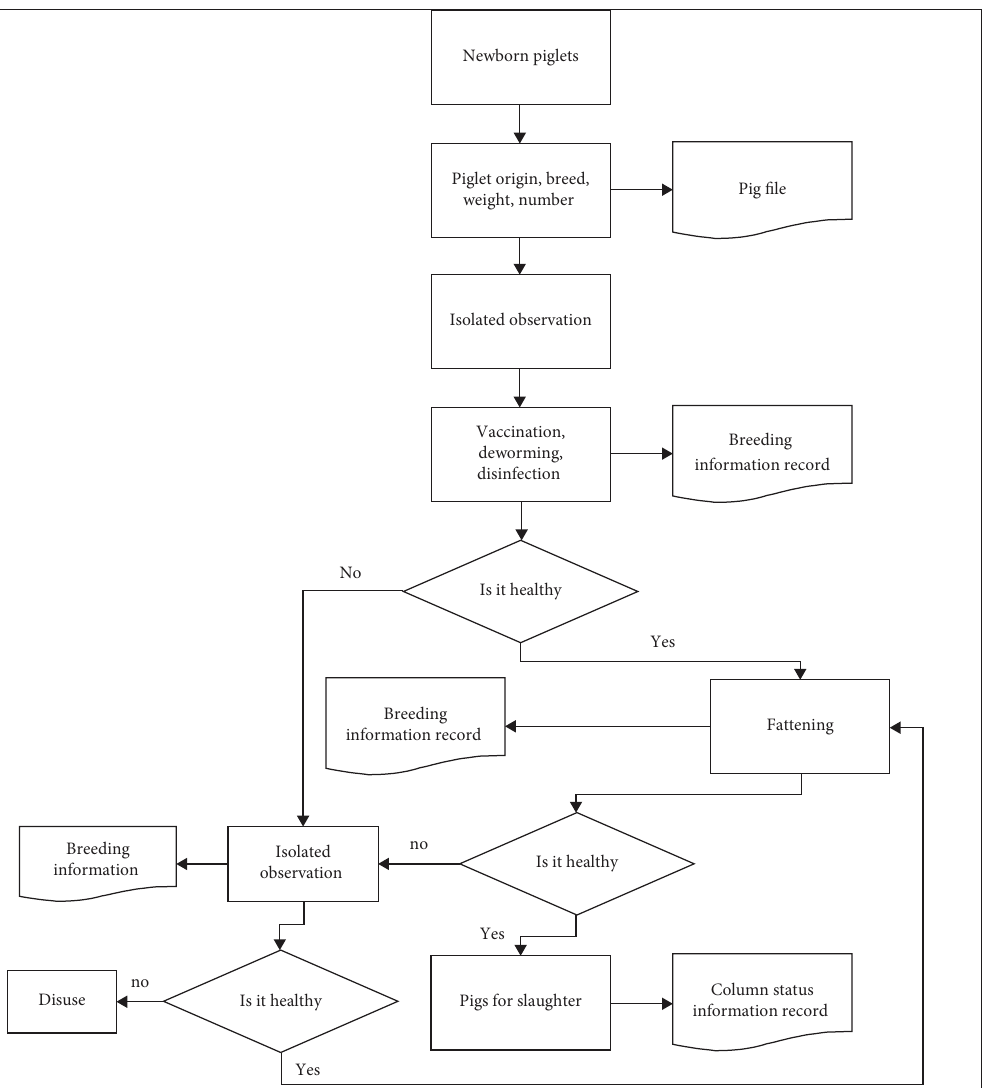
Figure 1: Flowchart of breeding information